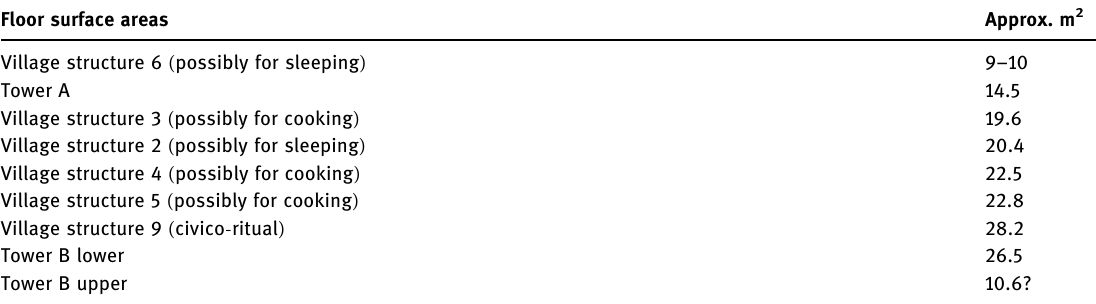
Table 1: Duos Nuraghes approximate fl oor surface areas ( m 2 ) of Towers A and B and village buildings 2 – 9 ( data from Webster, 2001